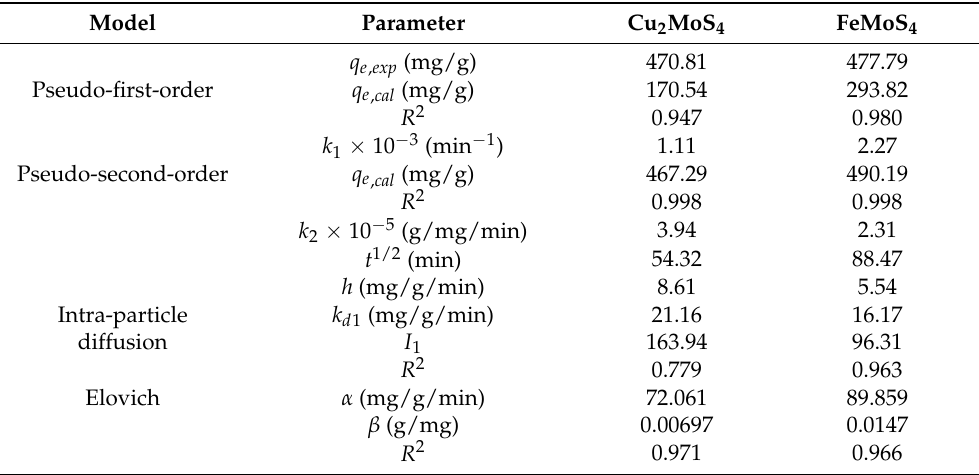
Table 1. Adsorption kinetics models parameters.